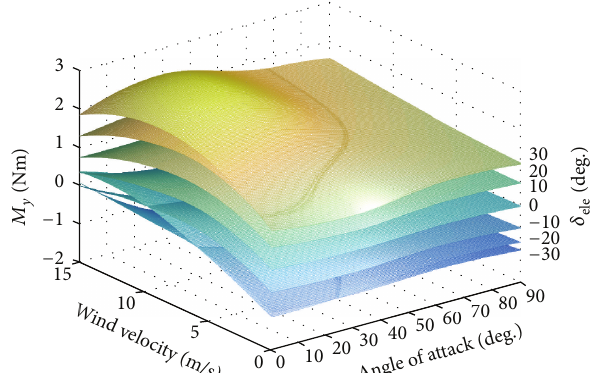
Figure 5: Wind tunnel test result for pitching moment.